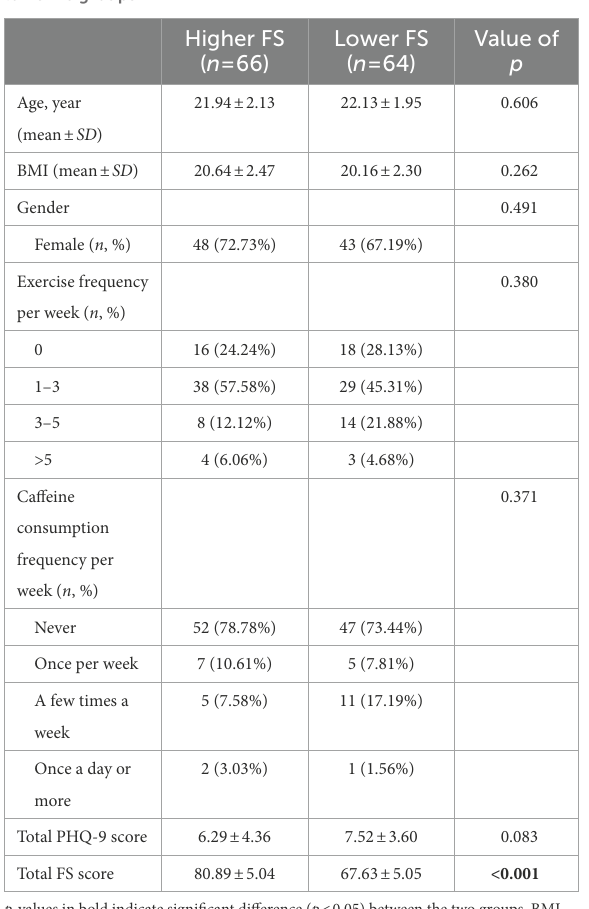
TABLE 1 Descriptive statistics of demographic data from higher and lower FS